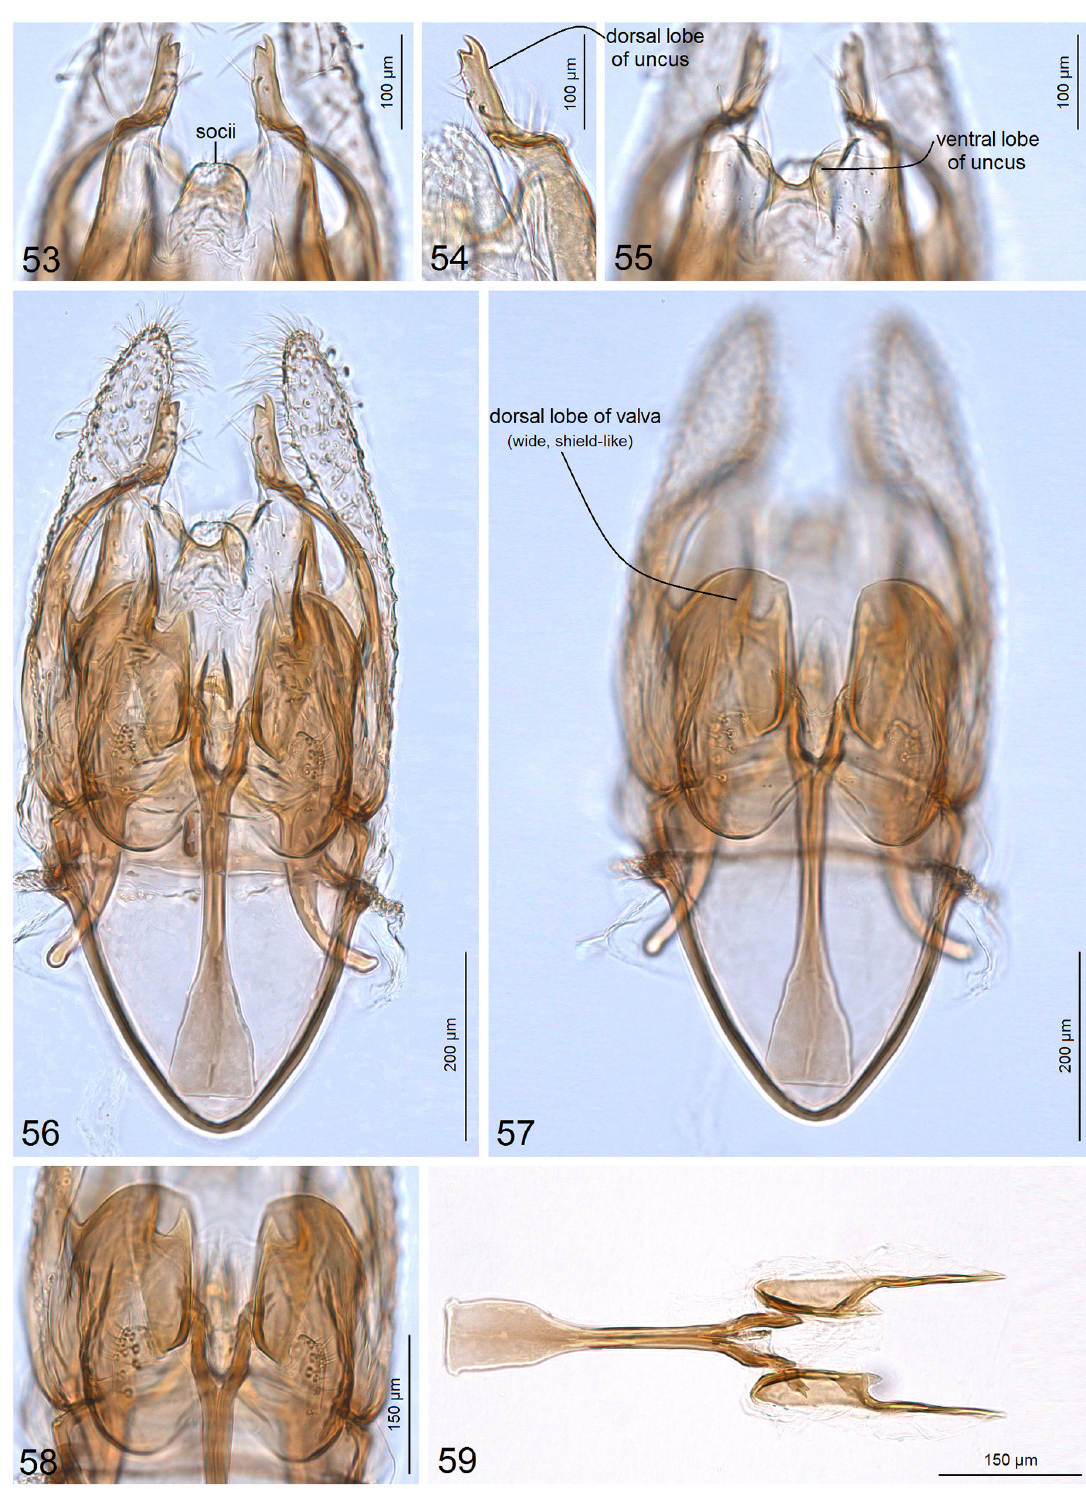
Figs 53–59. Male genitalia of Astrotischeria scutifera Diškus & Stonis sp. nov. (NHMUK). 53 . Socii, holotype (genitalia slide no. 010316175). 54 . Dorsal lobe of uncus, paratype (genitalia slide no. 010316177). 55 . Ventral lobes of uncus, holotype (genitalia slide no. 010316175). 56 . General view, holotype (genitalia slide no. 010316175). 57–58 . Same, shield-like lobe of valva. 59 . Phallus, paratype (genitalia slide no.